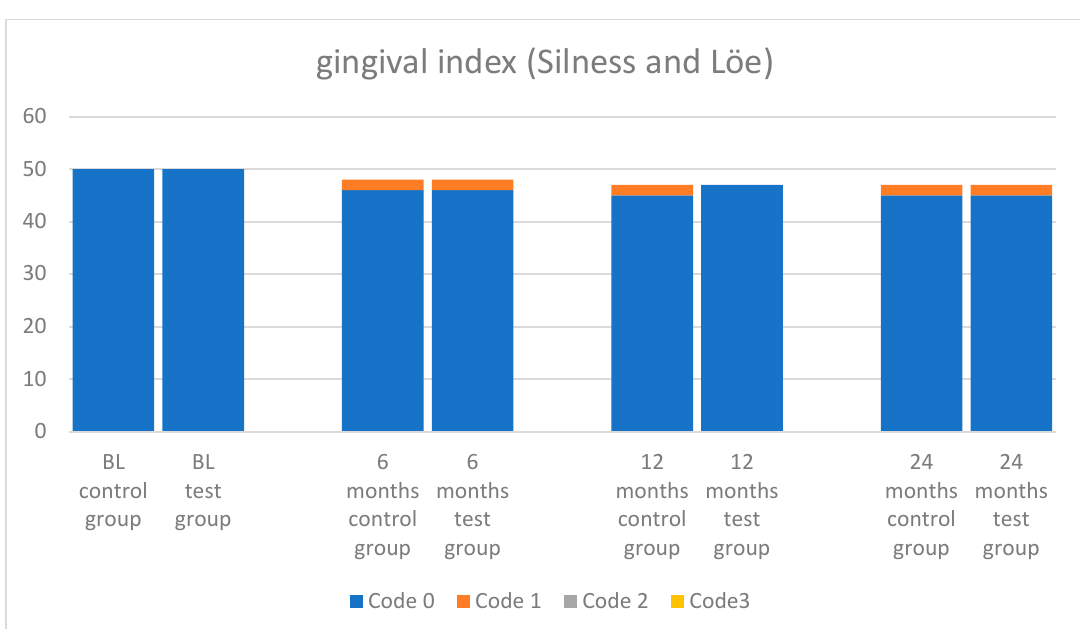
Figure 9. Gingival index (Silness and Löe) [22,23] .